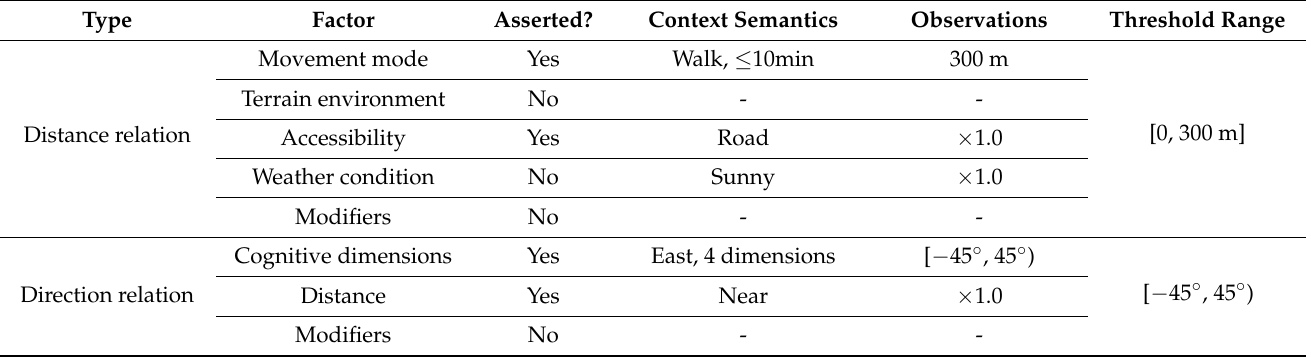
Figure 10. The contexts of compound spatial assertion in Q&A system. Table 3. Semantic analysis based on supervaluation of spatial assertion of Hubei Road